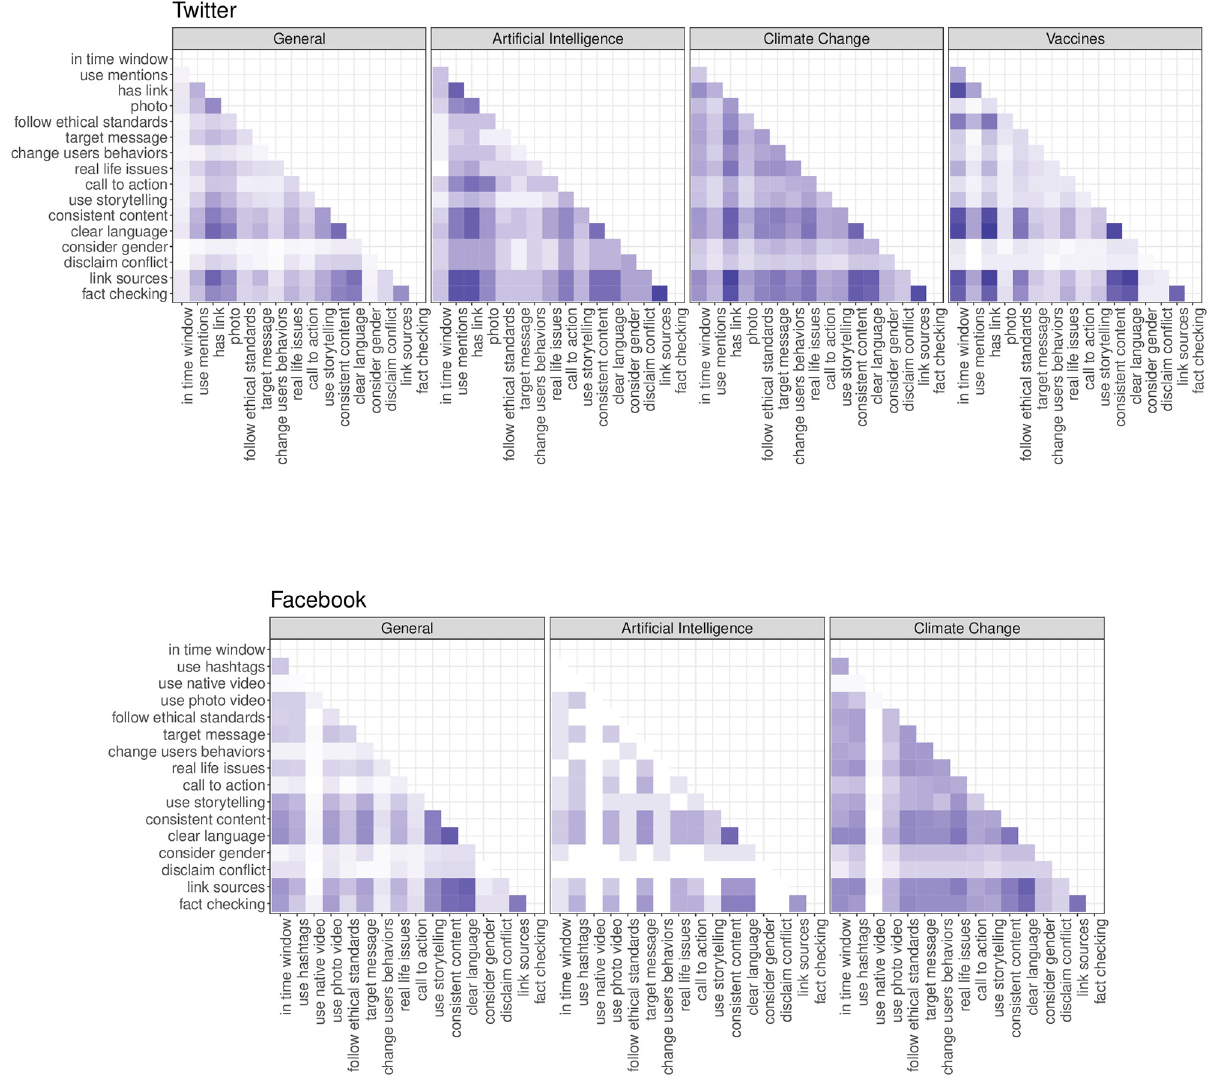
Fig 2. Co-occurrence of recommendation on social media platforms. Co-occurrence matrices displaying the proportion of recommendations applied together within the same posts for Twitter (top) and Facebook (bottom). Since the co-occurrence is a reciprocal quantity, the matrix is symmetric around the diagonal, thus only the upper triangular part is reported. As shown in the legend, darker colours indicate a higher co-occurrence of recommendations. In the case of Facebook, the topic Vaccines is missing due to the limited number of posts.